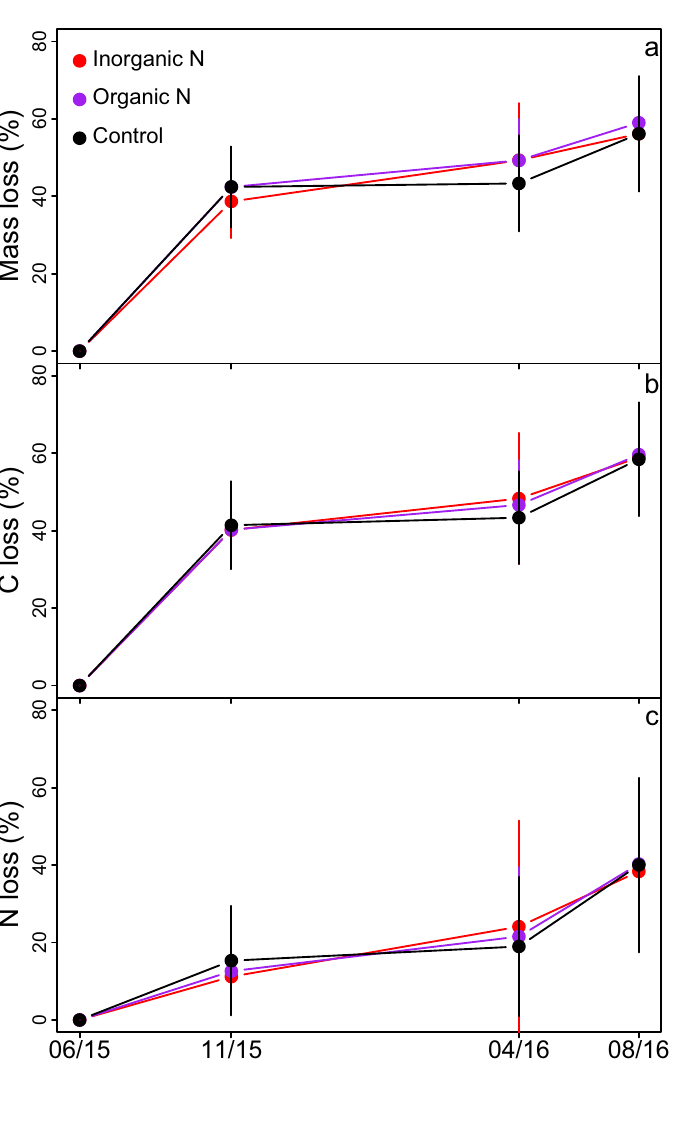
Fig 7. Impact of the fertilization treatments on litter decomposition. (a) Mass loss (%), (b) C loss (%), and (c) N loss (%) from the litter 114, 330, and 420 days after the litter bags were buried in the three experimental plots (inorganic N, organic N, and control